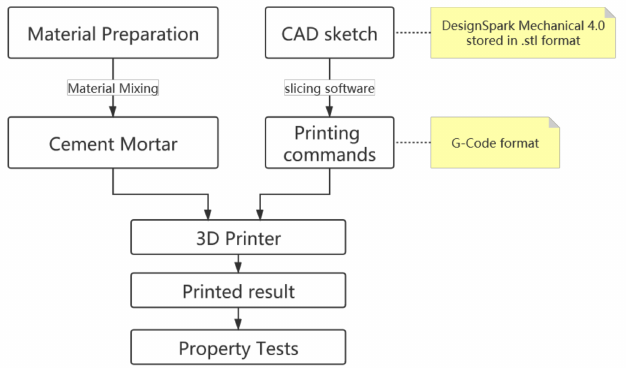
Figure 3. The 3D Printing